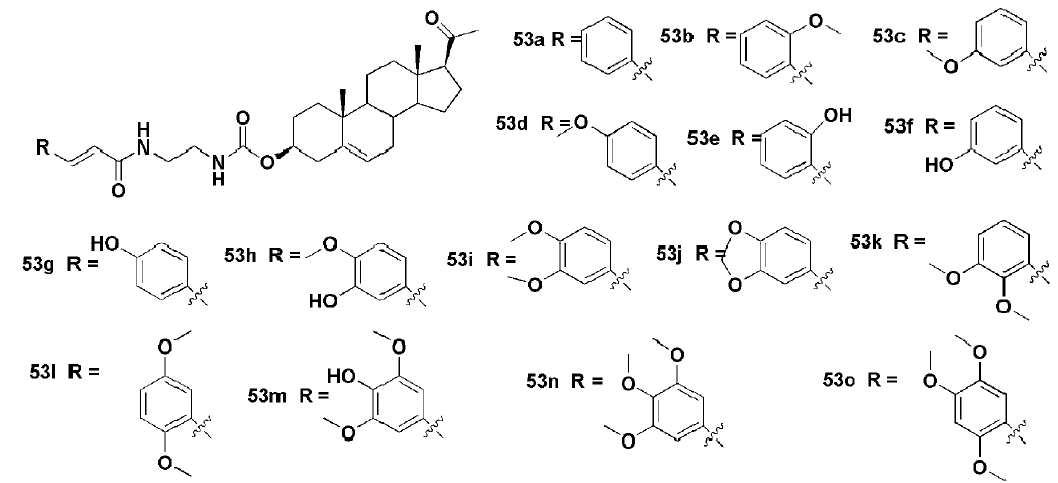
Figure 13. Chemical structures of designed and synthesized novel cinnamic acid-progenone hybrids ( 53a–o ) [31].